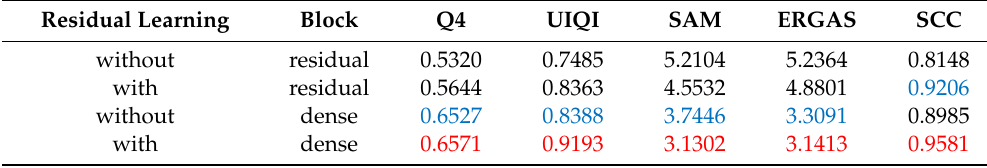
Table 10. Quantitative evaluation results of di ff erent architectures on the IKONOS dataset. The best and the second best results are in red and blue,